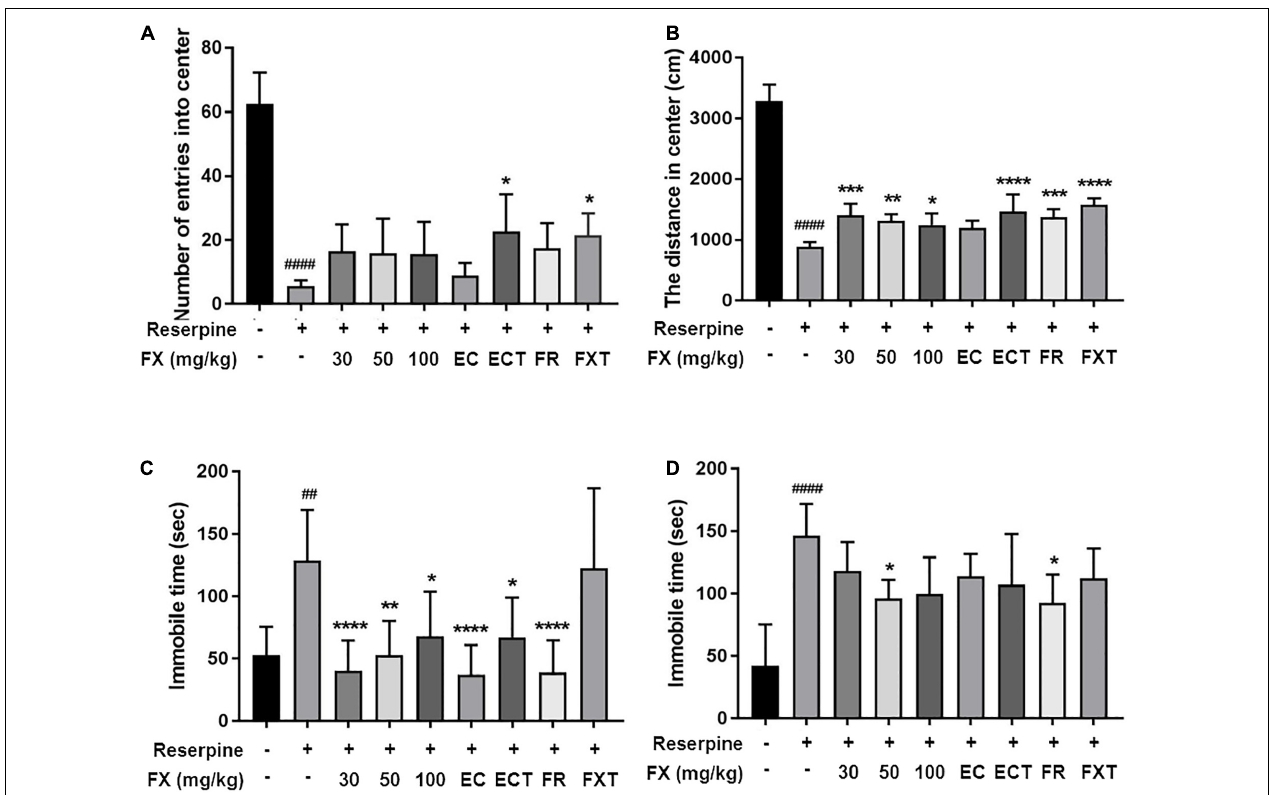
FIGURE 3 | Effect of FX extract and its components on performance in the OFT, TST, and FST. Mice were subjected to the (A,B) OFT ( n = 6), (C) TST ( n = 6), and (D) FST ( n = 8). FX extract, EC, ECT, and FR significantly improved reserpine-induced depressive behaviors. ## P < 0.01 and #### P < 0.0001 vs. normal group;